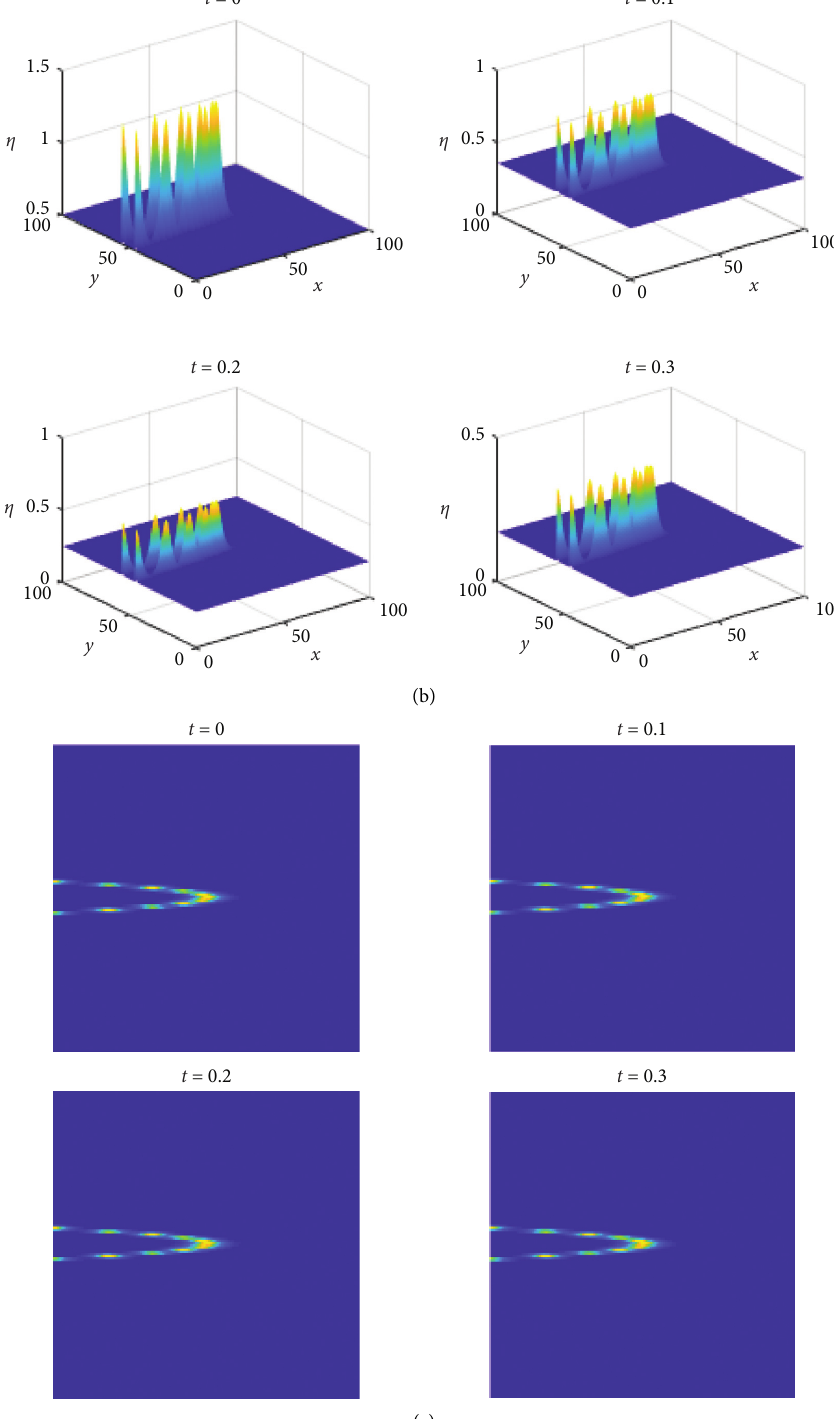
Figure 2: Numerical solution and pattern of Experiment 1 with initial condition η ( x,y, 0 ) � sin ( sec h (( x /2 ) + y 2 )) + 0 .